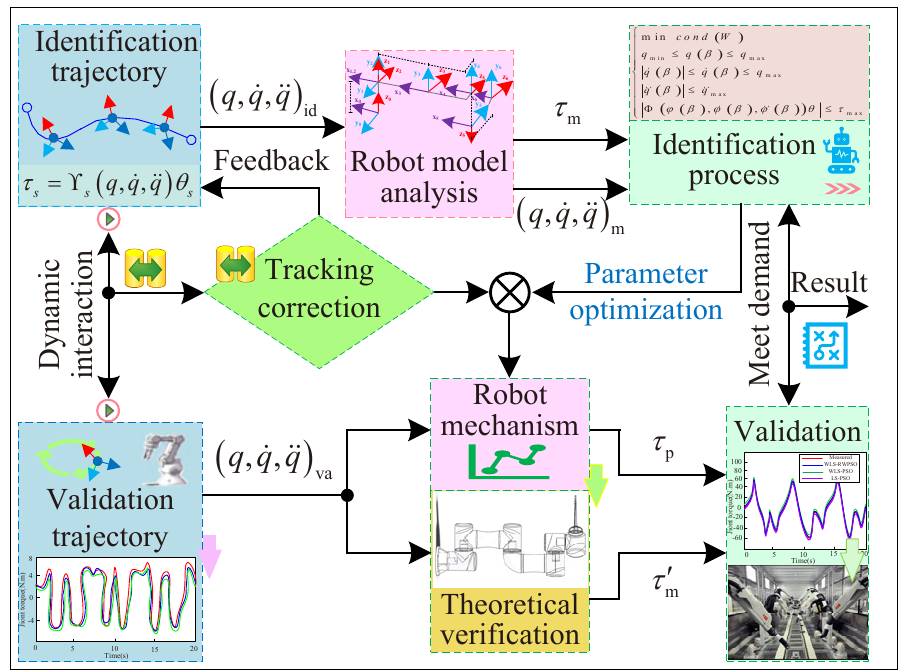
Figure 7. Flow chart of experimental